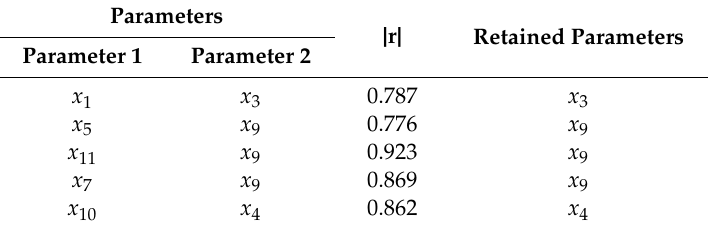
Table 3. Part of Pearson correlation coe ffi cient between process